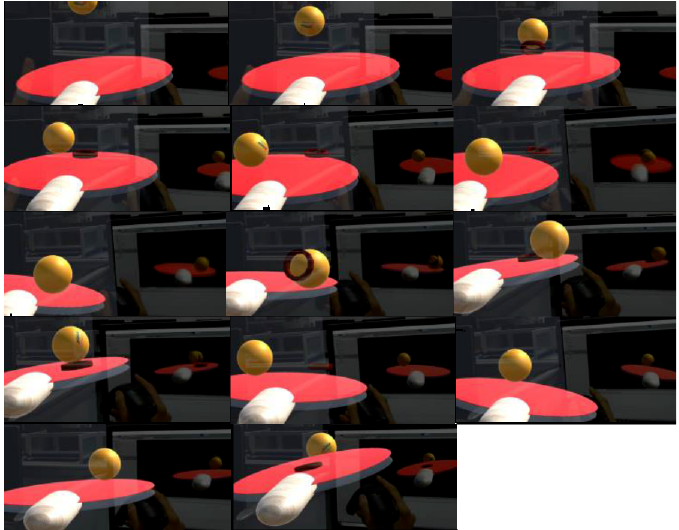
Figure 19. All of figures show simulated playing table tennis